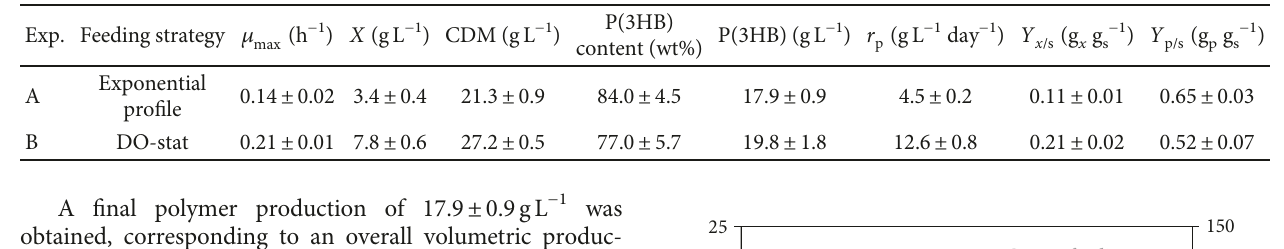
Table 1: Parameters obtained for cultivation of C. necator DSM 428 under fed-batch mode using an exponential feeding pro fi le (experiment A) and the DO-stat mode (experiment B) to feed UCO to the culture. μ dry mass; P(3HB) content: polymer content in the biomass; P(3HB): polymer concentration; r Y : storage yield. p/s